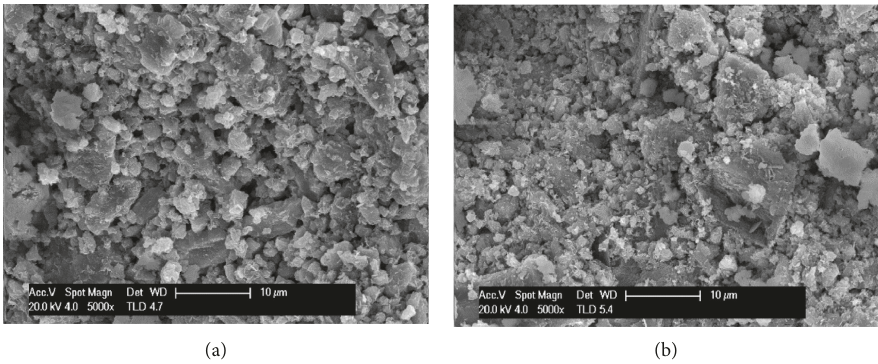
Figure 12: The SEM image of steel slag. (a) Without bacterial. (b) With bacterial.